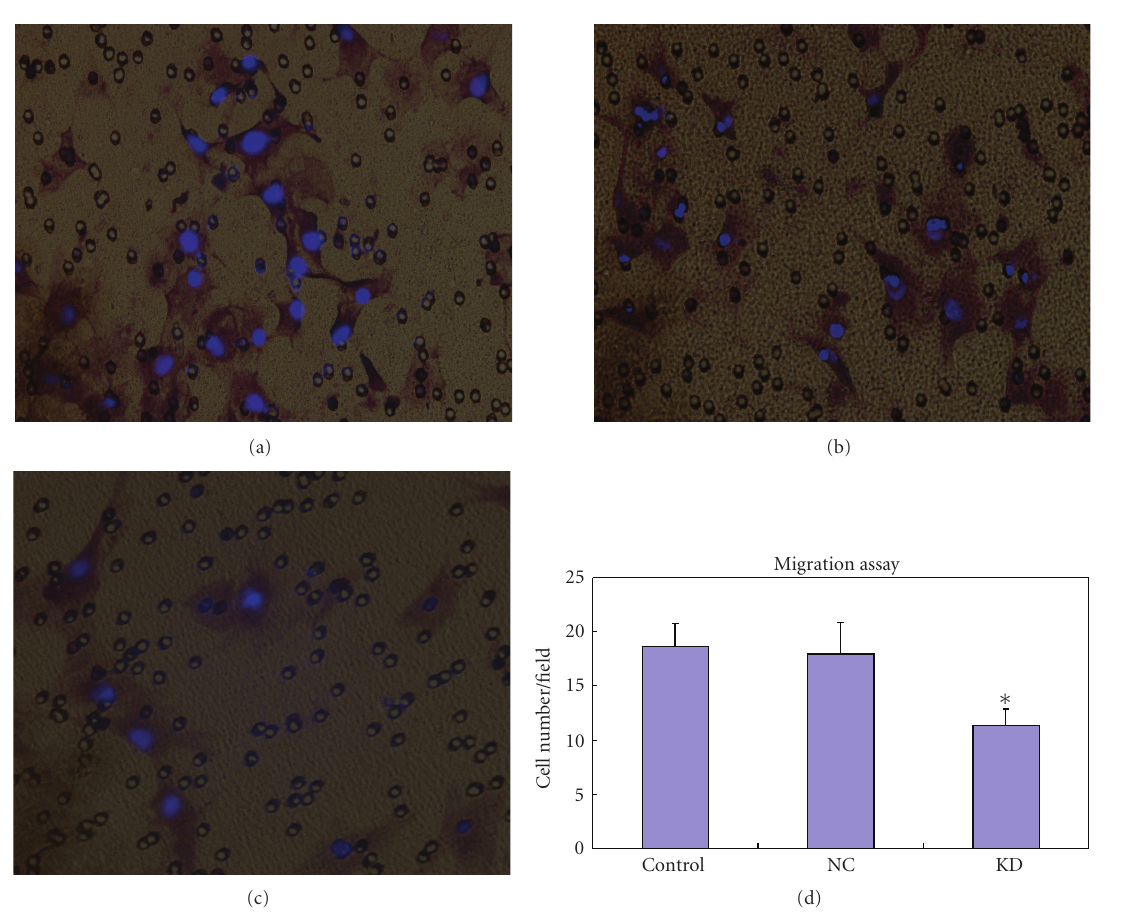
Figure 3: Knockdown of endogenous PDE4D inhibits PDGF-induced VSMC migration. PDGF-induced VSMC migration was assessed in a Boyden’s chamber. Representative images (a, b, c) and group data (d) are shown. (a)–(c) Representative photomicrographs illustrating migration of VSMCs. (a) Migration of VSMCs stimulated by PDGF-BB. (b) Migration of VSMCs stimulated by PDGF-BB in cells infected with lentivirus particles carrying nonsense shRNA. (c) Migration of VSMCs stimulated by PDGF-BB in cells infected with lentivrius carrying shRNA against PDE4D. (d) Bar graph illustrating PDGF-BB-induced VSMC migration in noninfected cells and cells infected with lentivirus particles carrying either PDE4D or nonsense shRNA. Numbers of migrated VSMCs were much less in cells infected with lentivrius carrying PDE4D shRNA compared with noninfected cells or cells infected with lentivirus particles carrying nonsense shRNA. Bars are the mean plus minus SEM of six random fields of view from three separate experiments. Original magnification, × 400. ∗ P less than.05 versus control. # P less than.05 versus nonsense